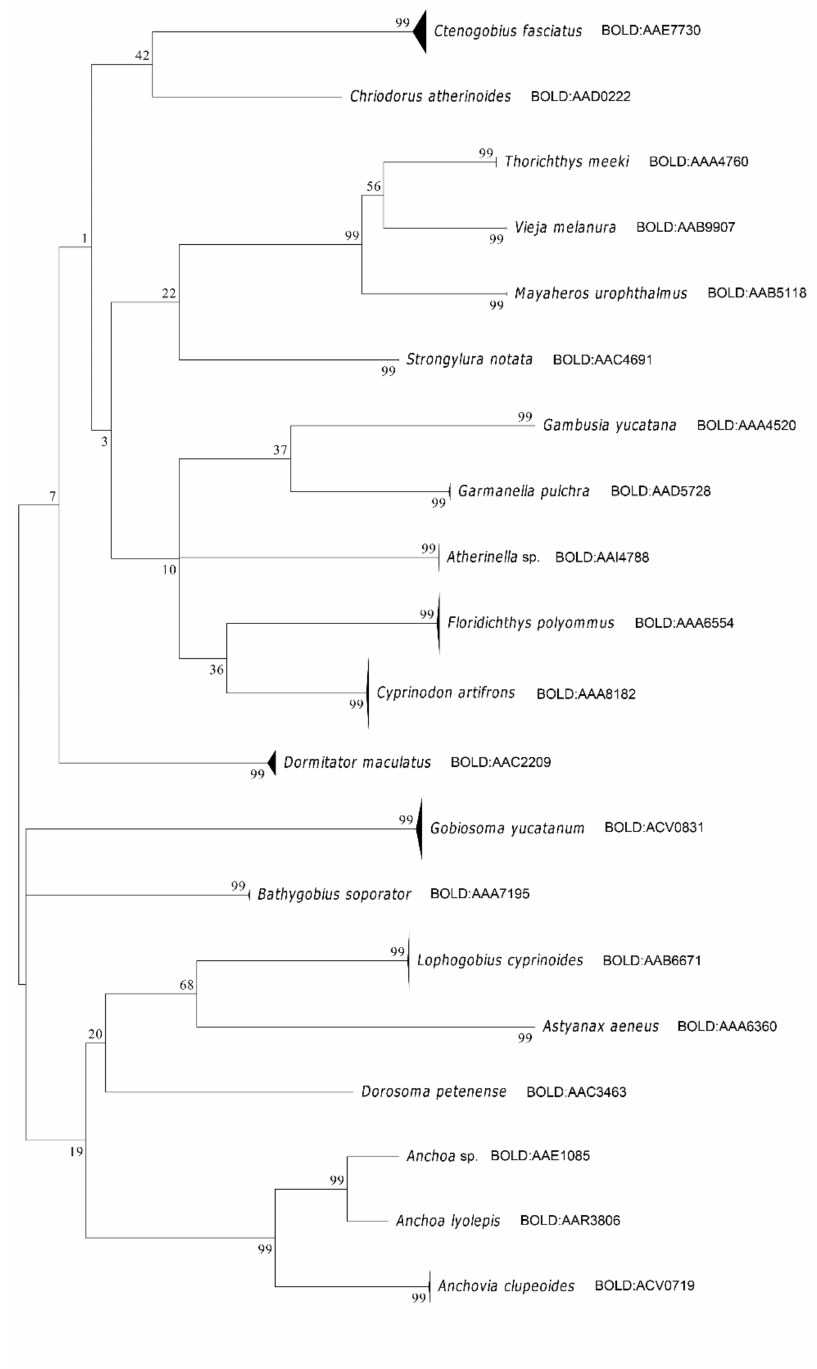
Figure 2. ML tree showing the clustering of the 20 identified species. The numbers on the branches are the bootstrap support after 500 replicates. Numbers after the names are the